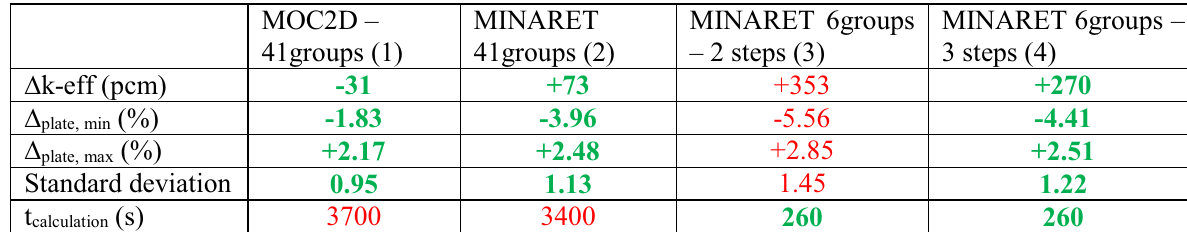
Table I. Bias with TRIPOLI-4 ® on k-eff and fission rate/plates for the different core